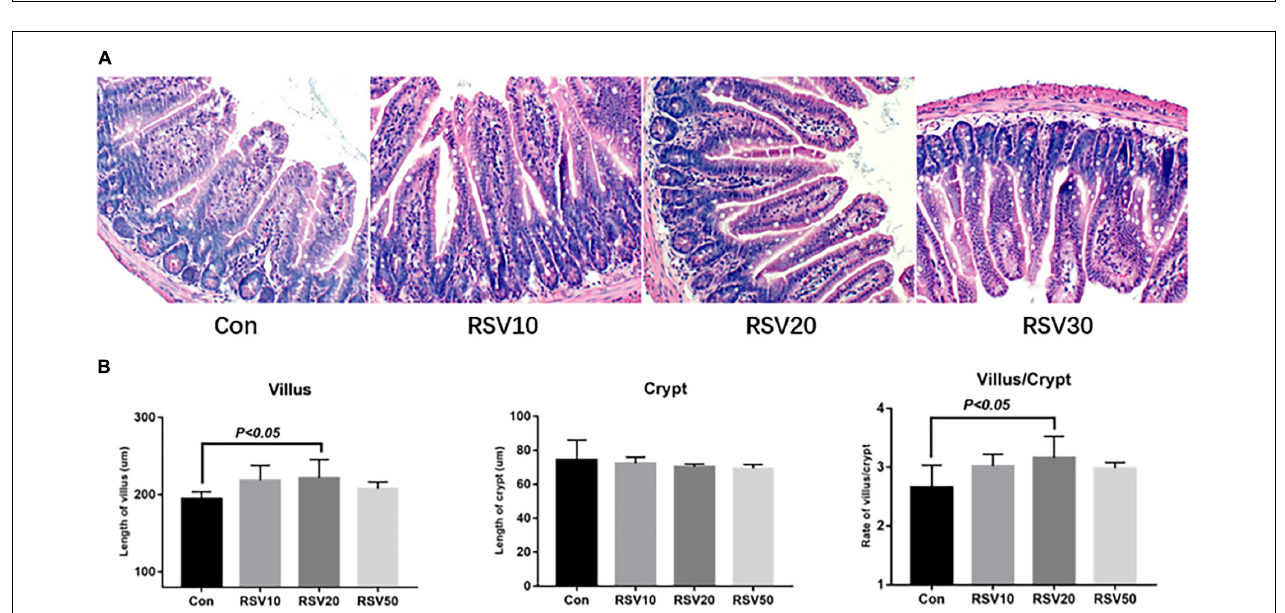
FIGURE 1 | Effect of RSV on body weight and feed intakes of weaned mice. (A) Average daily gain per mice in each group. (B) Average daily feed intake of mice in each group. Con = control group, RSV10 = 10 mg/kg RSV, RSV20 = 20 mg/kg RSV, RSV50 = 50 mg/kg RSV. **Means with double asterisks are significantly different ( p < 0.01) from values of control group, and all the data are expressed as the means ± SEM.